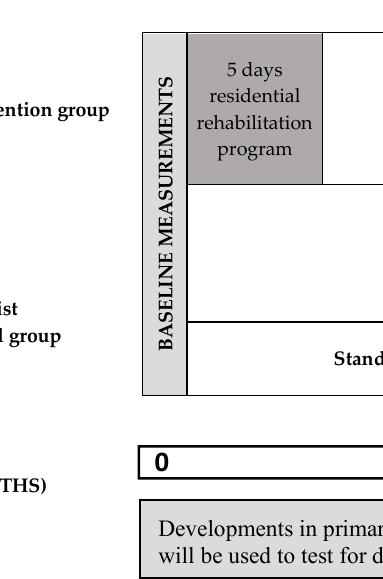
Figure 1. Timeline of the NUTRI-HAB trial from baseline to 3-month follow-up.